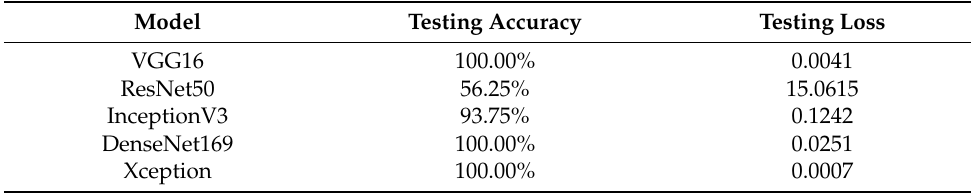
Table 3. Testing accuracies and testing loss when tile size of 250 × 250 pixels was used.